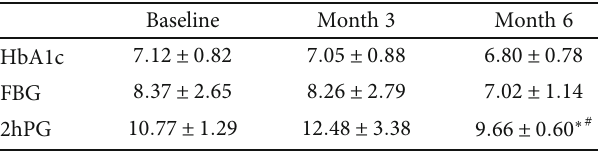
Table 7: Change in blood glucose